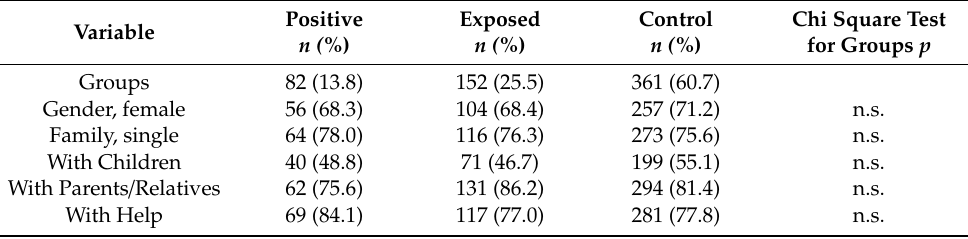
Table 1. Socio-demographic characteristics of the